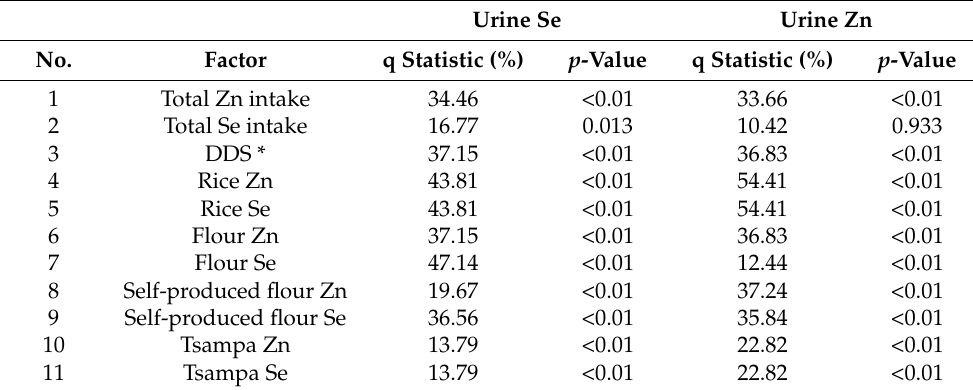
Table 1. q-statistics of different factors on urine Se and